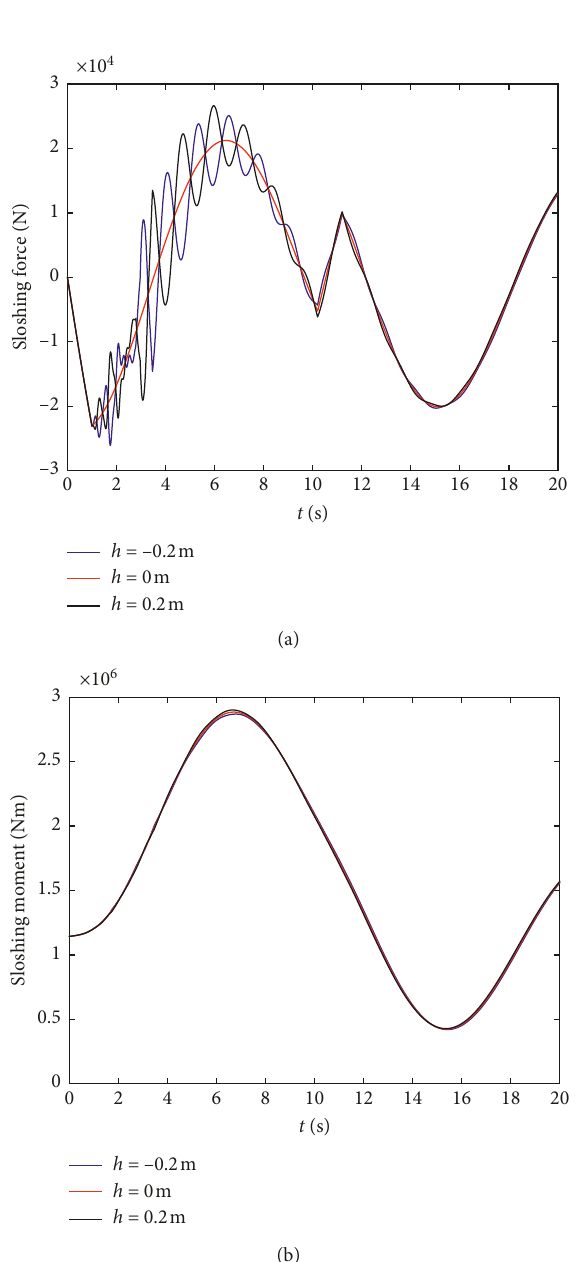
Figure 12: Road bump effect on liquid sloshing during vehicle braking: (a) sloshing force; (b) sloshing